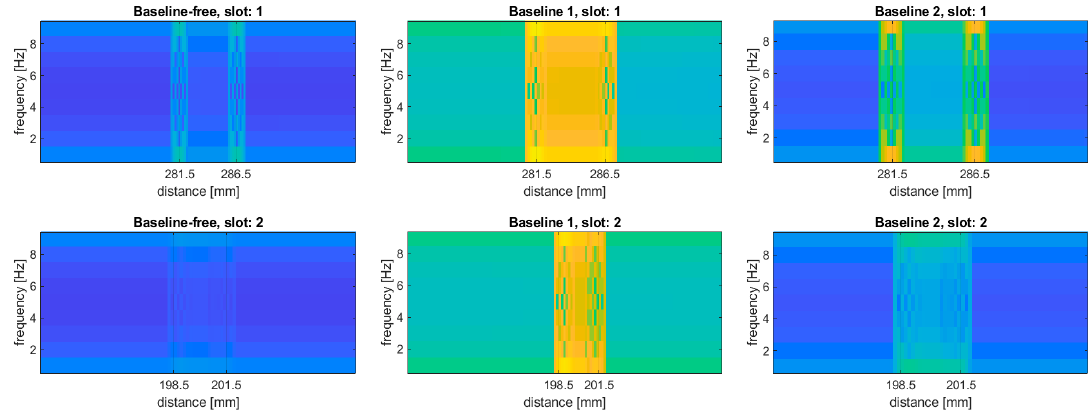
Figure 9. The exemplary results of the quantification of the damage width. Table 3. The results of quantification of the damage depth.